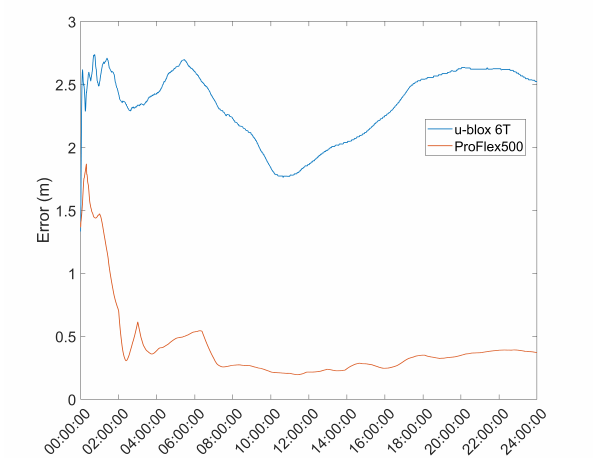
Figure 11. Auto-survey results for the u-blox 6T and ProFlex receivers for a 24 h